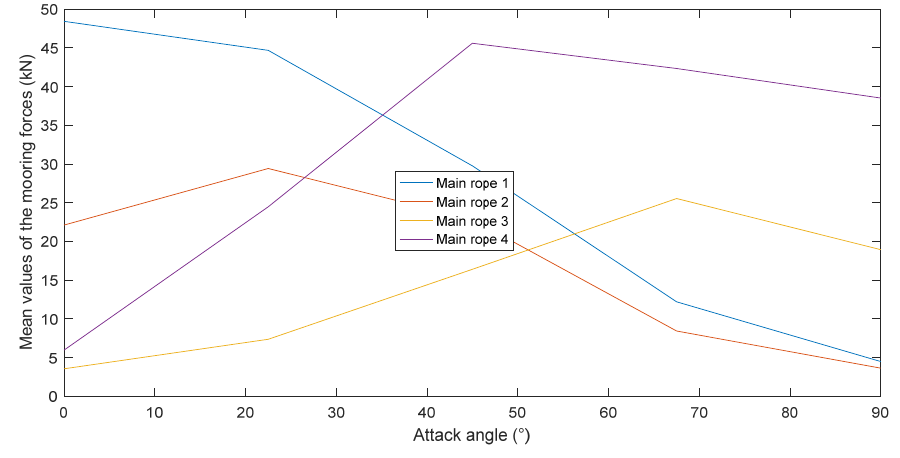
Figure 11. Mean values of mooring forces for Main ropes 1–4.